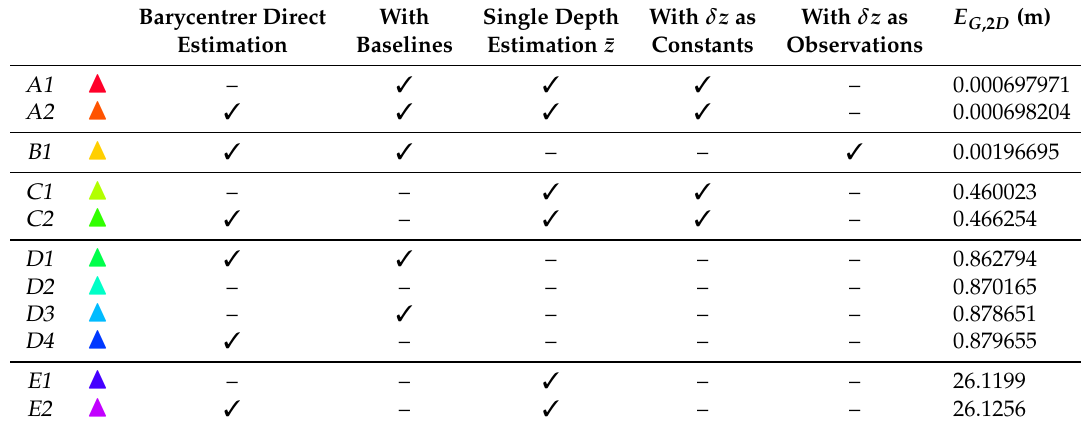
Table 1. Distance to true barycenter for different inversion protocols for a drifting trajectory inscribed in a 10m radius circle.